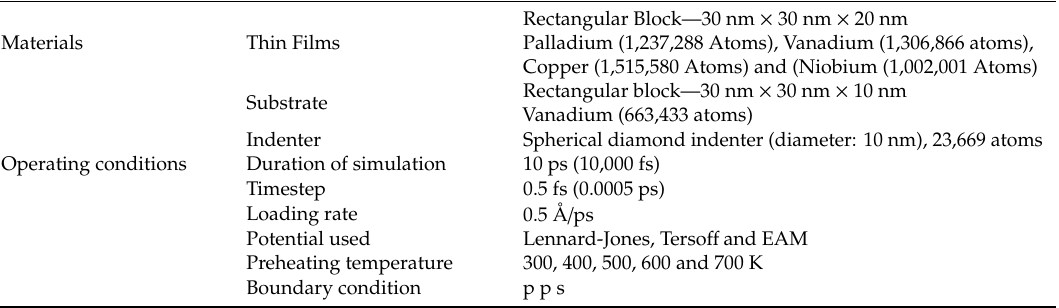
Figure 1. Simulation model snapshot. Table 1. Schematic calculation plan used in the molecular dynamic (MD)